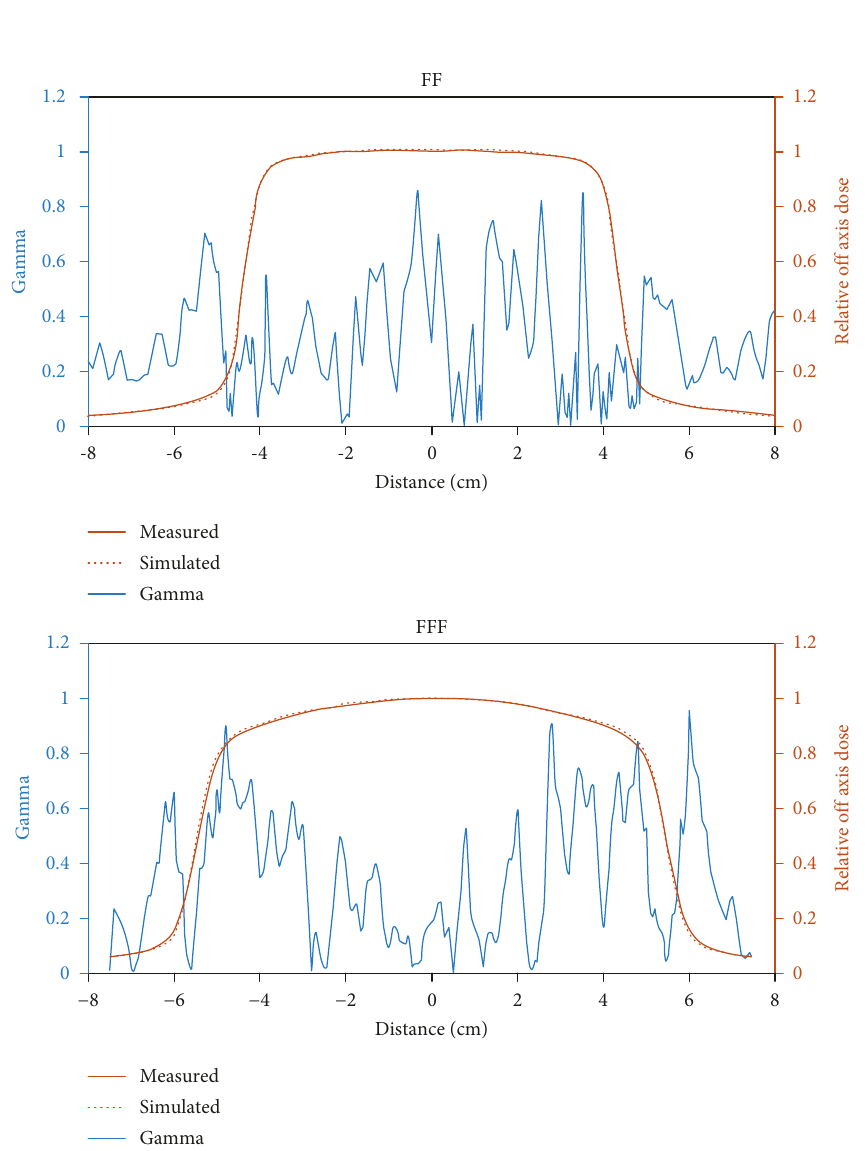
Figure 10: The gamma analysis results of measured and simulated off-axis doses produced by FF and FFF beams for 10 × 10cm 2 field at 10cm depth (Distance-To-Agreement:1mm, Dose Difference:1%). The blue curve represents the gamma value; the solid red line represents the measured off-axis dose; and the dotted red line represents the simulated off-axis